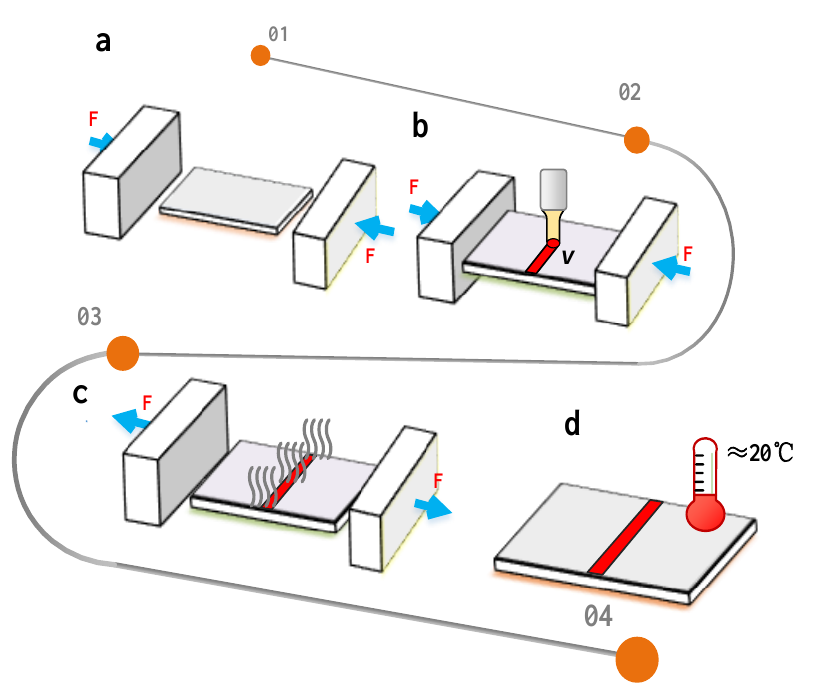
Figure 2. The specific process of BPM: ( a ) baffle application, ( b ) heating in progress, ( c ) removal of baffle and ( d ) cooling stage.